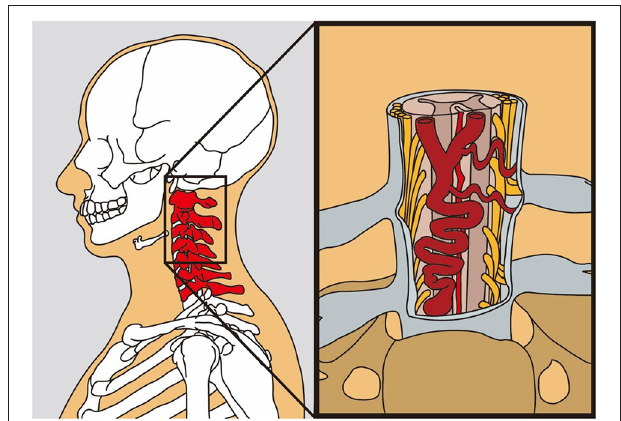
FIGURE 5 | The schematic model of the dural arteriovenous fistula (AVF) lying in the ventral aspect of the cervical spinal cord (this figure is an artwork produced by Mr. Huang for us; he had kindly permitted us to publish his work in our